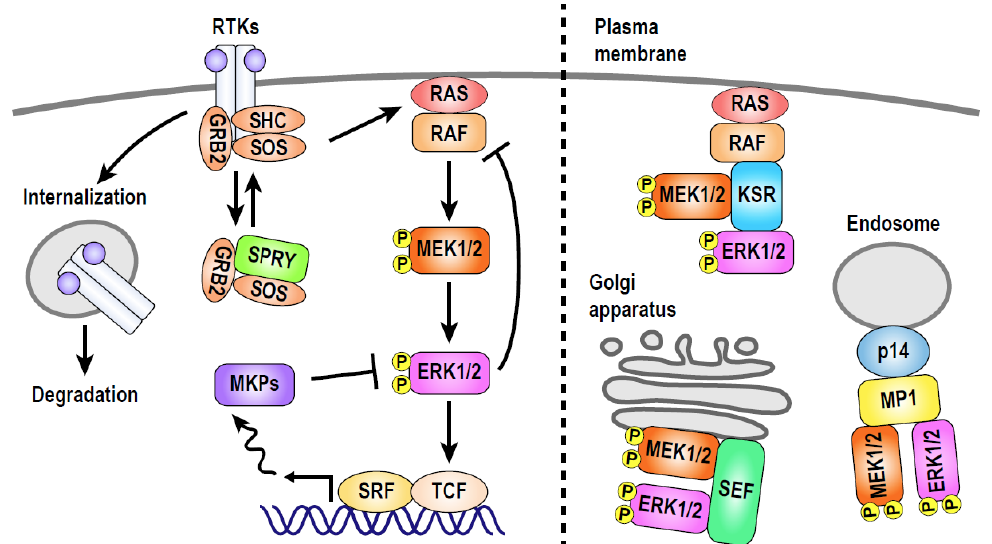
Figure 1. Factors affecting spatiotemporal dynamics of extracellular signal-regulated kinase (ERK) activity. The temporal patterns of ERK activation are defined by several feedback mechanisms. Ligand-induced activation of receptor tyrosine kinases (RTKs) causes their internalization and the